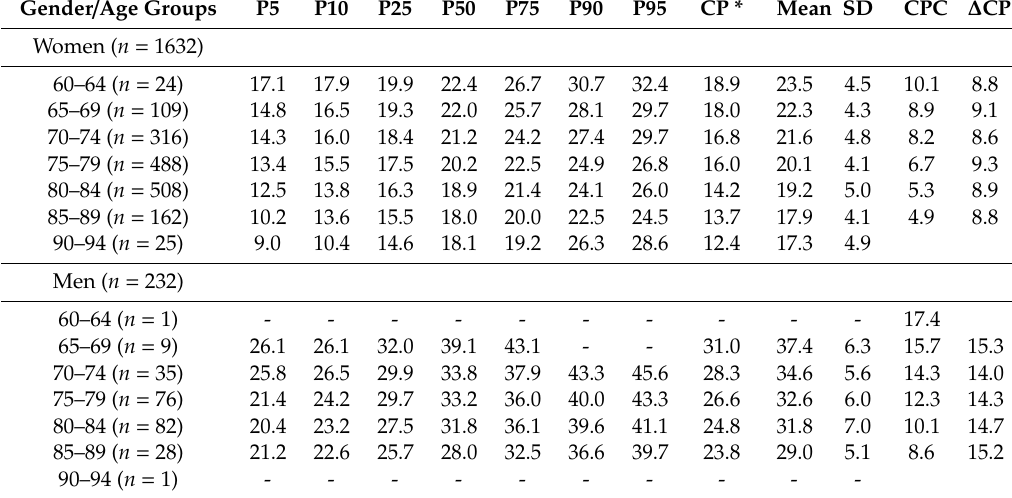
Table 2. Age-specific and gender-specific percentiles for handgrip strength (HSG) and the cut-o ff point values compared with the Colombian population. Gender / Age